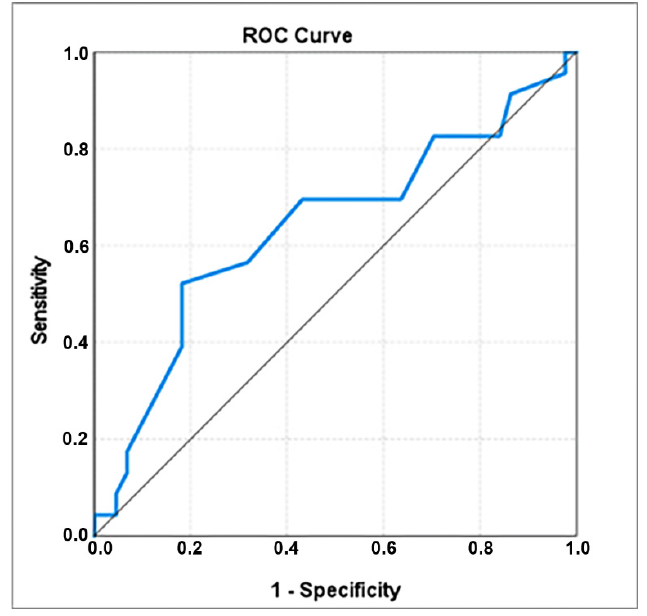
Figure 2. ROC curve for age.